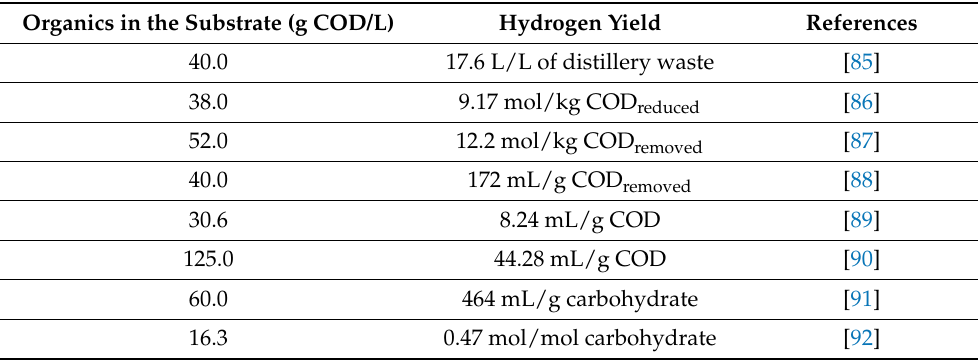
Table 4. Hydrogen yields from distillery waste. Organics in the Substrate (g